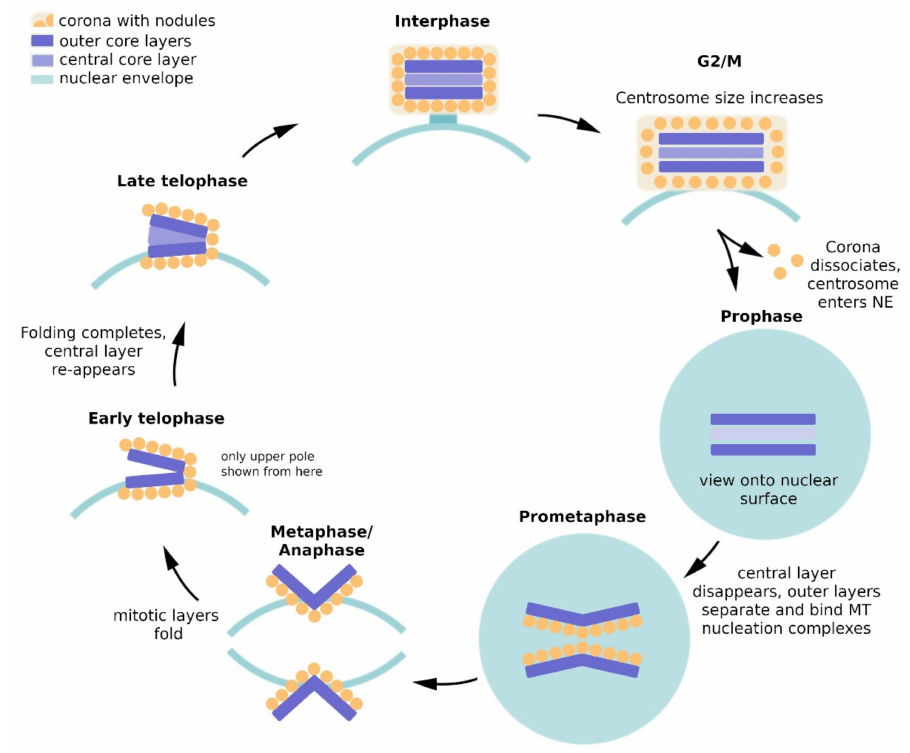
Figure 2. The Dictyostelium centrosome cycle. Nuclei and centrosomes are shown in schematic cross sections, except for the prophase and prometaphase images where a surface view is shown. See text for a detailed description. Redrawn and adapted from